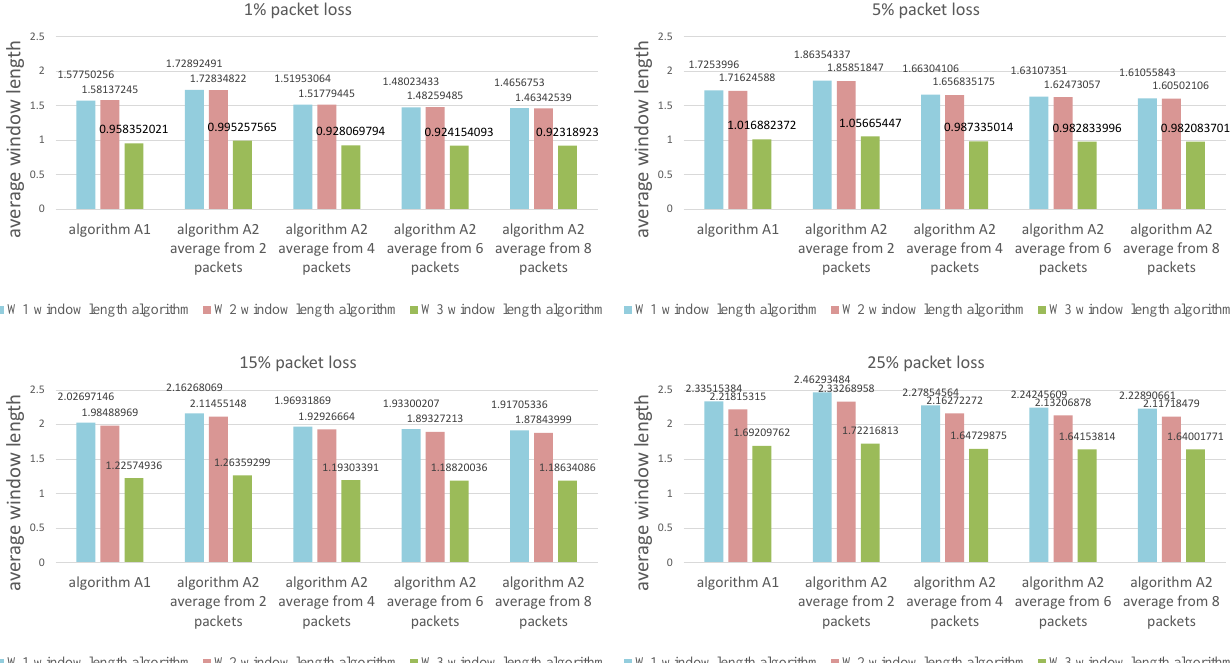
Figure 11. Comparison of algorithms in terms of the average length of the listening